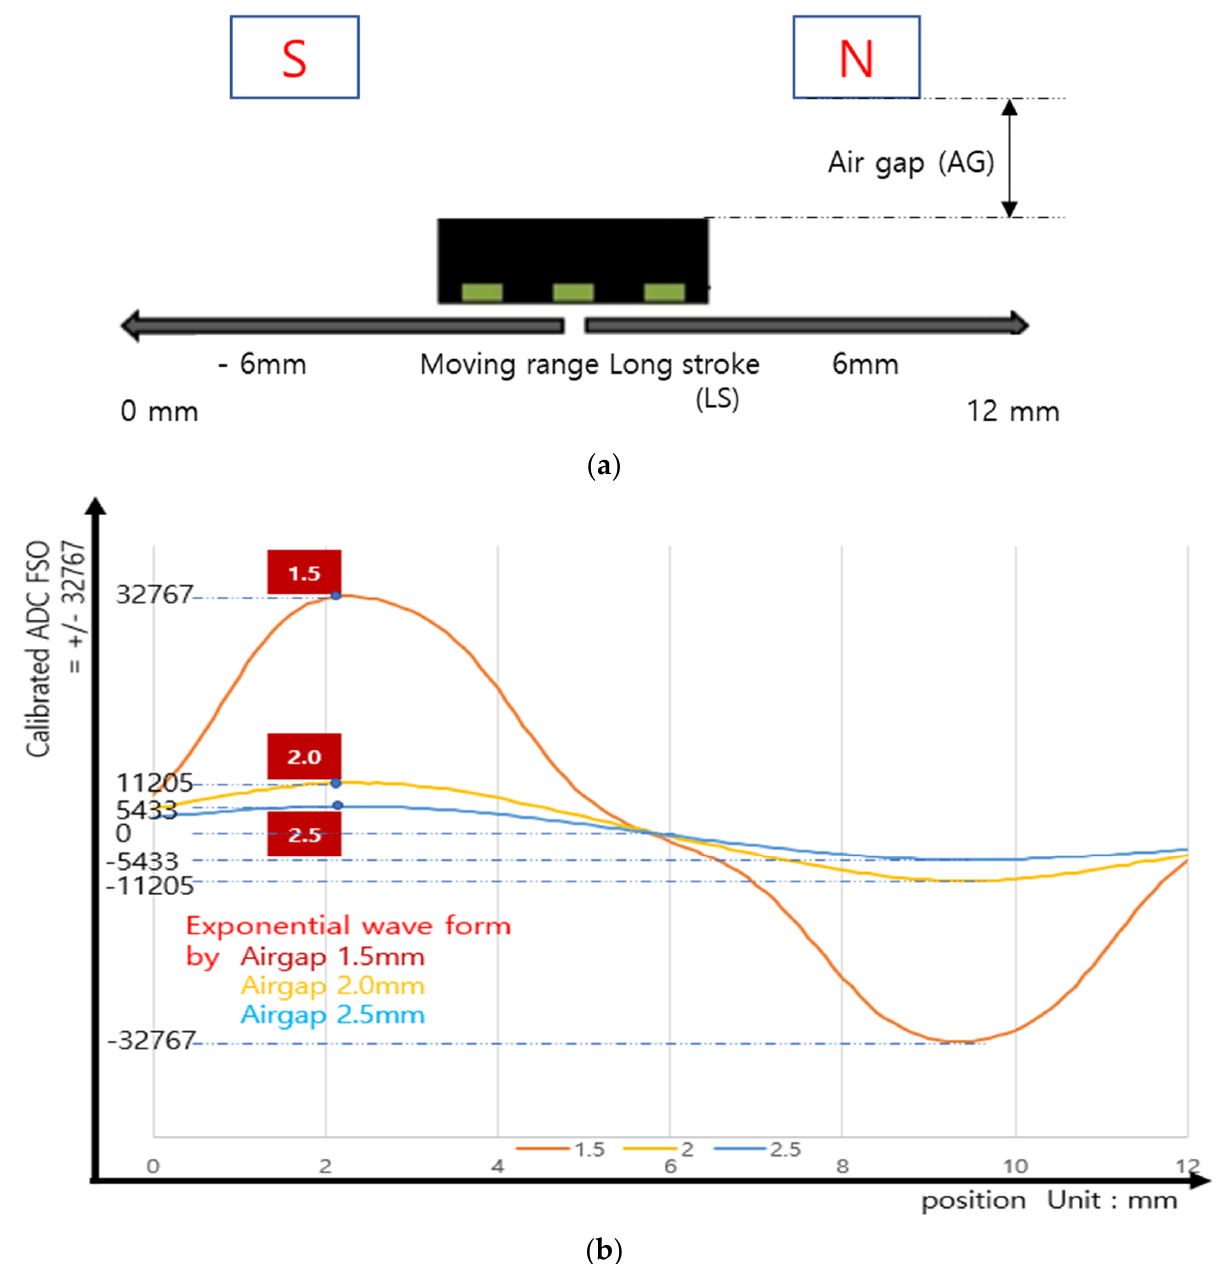
Figure 5. ( a ) Illustration of the 3D Hall sensor airgap and moving range. ( b ) 3D Hall sensor raw data for change in analog–digital converter (ADC) amplitude with ±6 mm moving range and various airgaps.